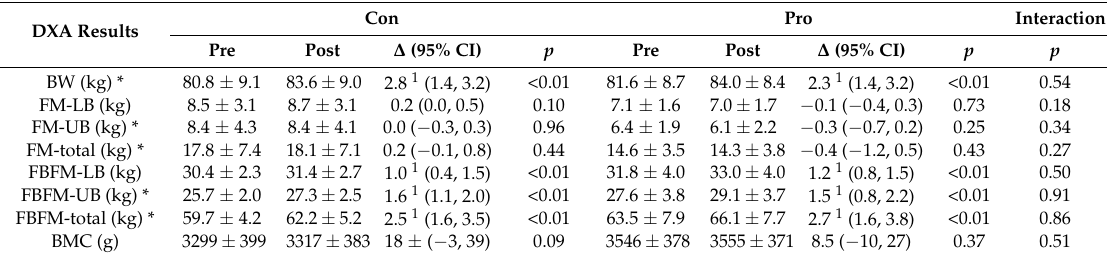
Table 2. Body composition before (Pre) and after (Post; week 9) training.